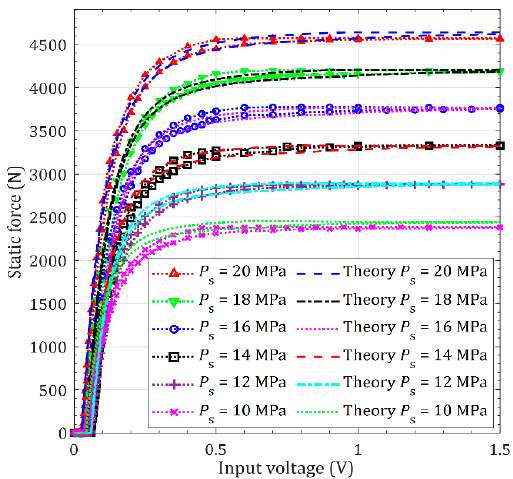
Figure 10. Simulink block diagram of the nonlinear static force model of the actuator with flow controlled with servo valve.